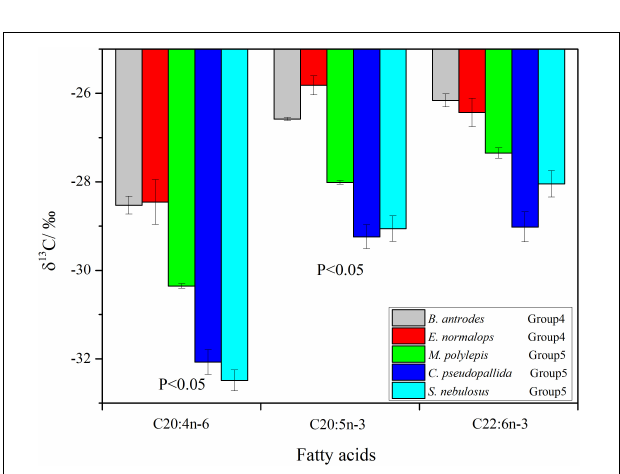
FIGURE 5 | Compound-specific 13 C of fatty acids ( Bathygadus antrodes and Evermannella normalops classified as non-migrant piscivorous fishes; Melamphaes polylepis , Cyclothone pseudopallida and S. nebulosus classified as semi-migrant piscivorous